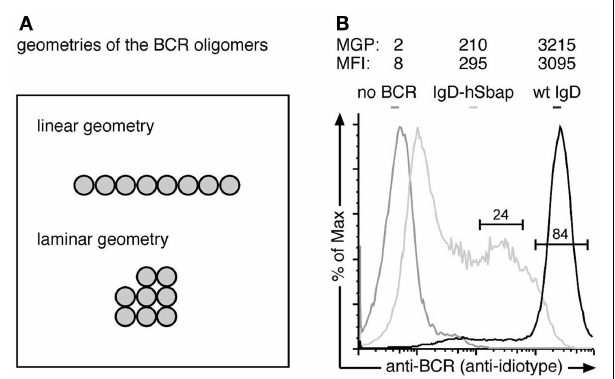
FIGURE 3 |The anti-BCR immuno-gold-labeling is specific . (A) The Monte-Carlo simulations were performed for two possible BCR oligomer geometries: a linear and a laminar geometry. (B) J558L δ m/mb-1flN cells expressing the wt IgD-BCR (black line), J558L cells without any BCR (dark gray line) or IgD-hSbap BCR-expressing J558L (light gray line) were labeled with the anti-BCR antibody Ac146 and subsequently stained with FITC-labeled anti-mouse IgG or gold-coupled anti-mouse IgG antibodies. Fluorescently labeled cells were analyzed by flow cytometry, and mean fluorescent intensities (MFI) of the gated populations are given. Gold labeled cells were subjected to replica preparation and analyzed byTEM. The mean gold particle (MGP) number detected on the cell replicas confirms specific labeling of the BCR on wt and IgD-hSbap expressing J558L cells, while immuno-gold-labeling of J558L not expressing BCR does not result in significant gold particle detection on surface replicas.